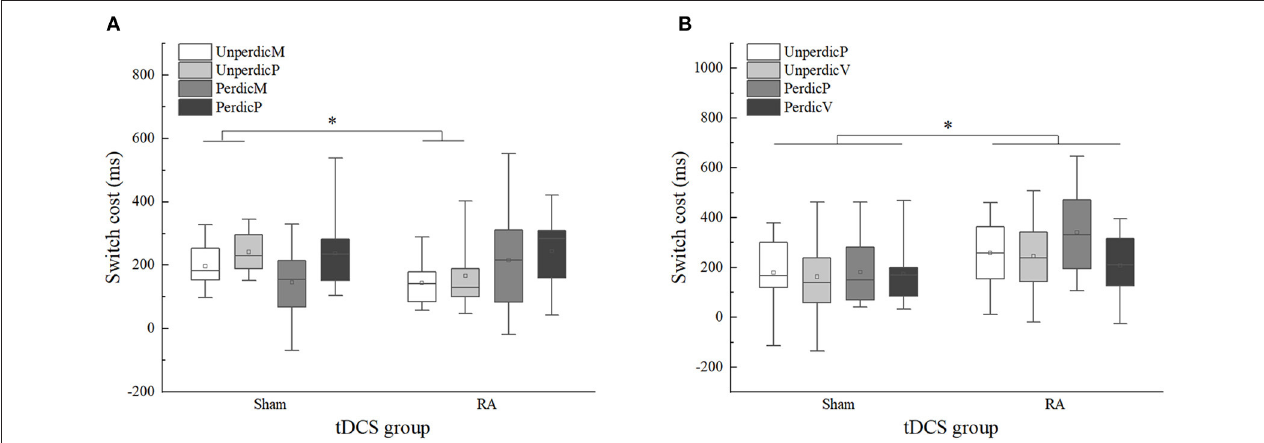
FIGURE 5 | Switch cost of sham and right anode (RA) tDCS groups in the parity/magnitude and parity/vowel-consonant task in different task context. (A) Switch cost in the parity/magnitude task. (B) Switch cost in the parity/vowel-consonant task. UnperdicM, unpredictable magnitude task; UnperdicP, unpredictable parity task; UnperdicV, unpredictable vowel-consonant task; PerdicM, predictable magnitude task; PerdicP, predictable parity task; PerdicV, predictable vowel-consonant task. * p < 0.05.